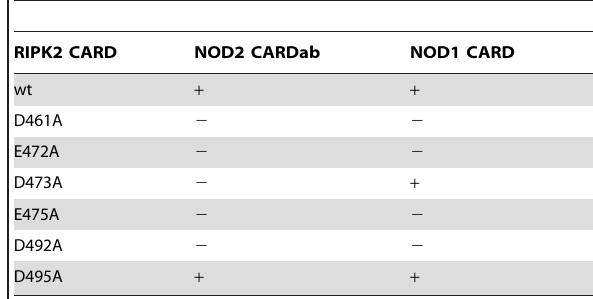
Table 3. The interaction of NOD2 CARDab mutants with the CARD of RIP2.